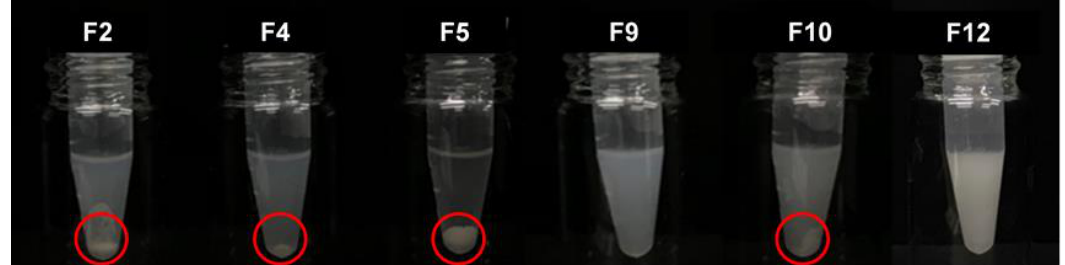
Figure4. VisualobservationofPSPformulationsdispersedinwater. Figure 4. Visual observation of PSP formulations dispersed in water. Open circles indicate PPD precipitation.